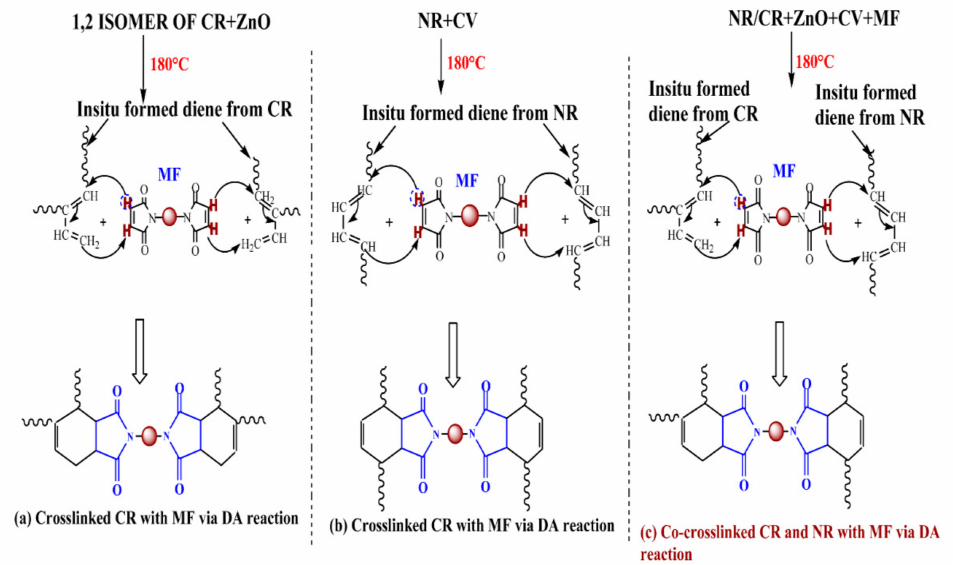
Figure 4. Plausible reactions in NR/CR blend during curing with MF in conjunction with the accelerated sulfur system.